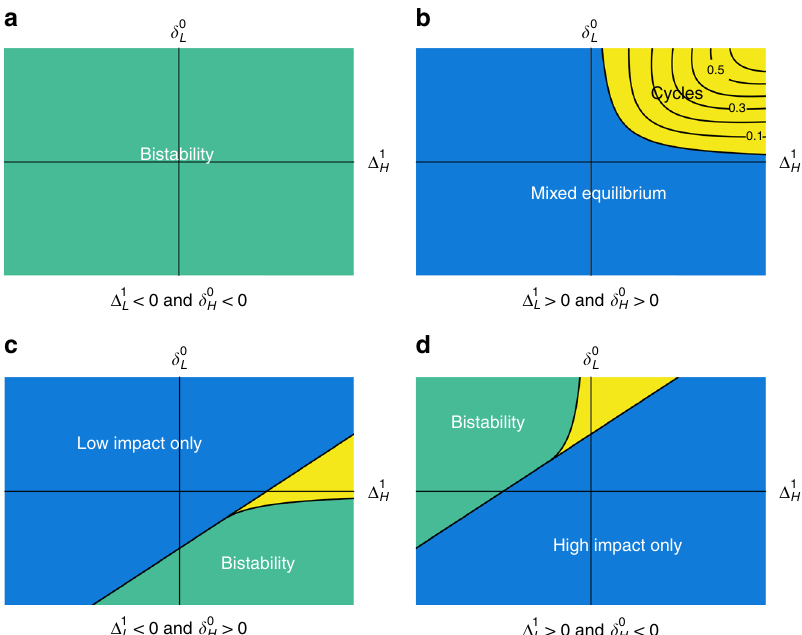
Fig. 2 Dynamical outcomes of linear eco-evolutionary games. Each panel shows the dynamical outcomes for different regimes of incentives to lead strategic change, Δ 1 and δ 0 . Yellow regions denote parameter regimes that can produce limit cycles, provided ϵ < ϵ crit , with level curves of ϵ crit shown as H L black lines. Blue regions represent regions with a single dynamical outcome. Green regions represent bistability. a Outcomes when the incentives to lead strategic change are both negative. b Outcomes when incentives to lead strategic change are both positive. c , d Outcomes when incentives to lead strategic change are mixed. In these cases the yellow regions can exhibit bistability, dominance by one strategy, or cycles that occur in a bistable regime; the value of ϵ determines which of these outcomes occur. “ Renewable resource system-level analysis ” in Supplementary Note 1 provides analytical expressions for the boundaries between these dynamical regimes, in terms of the incentive parameters Δ 1